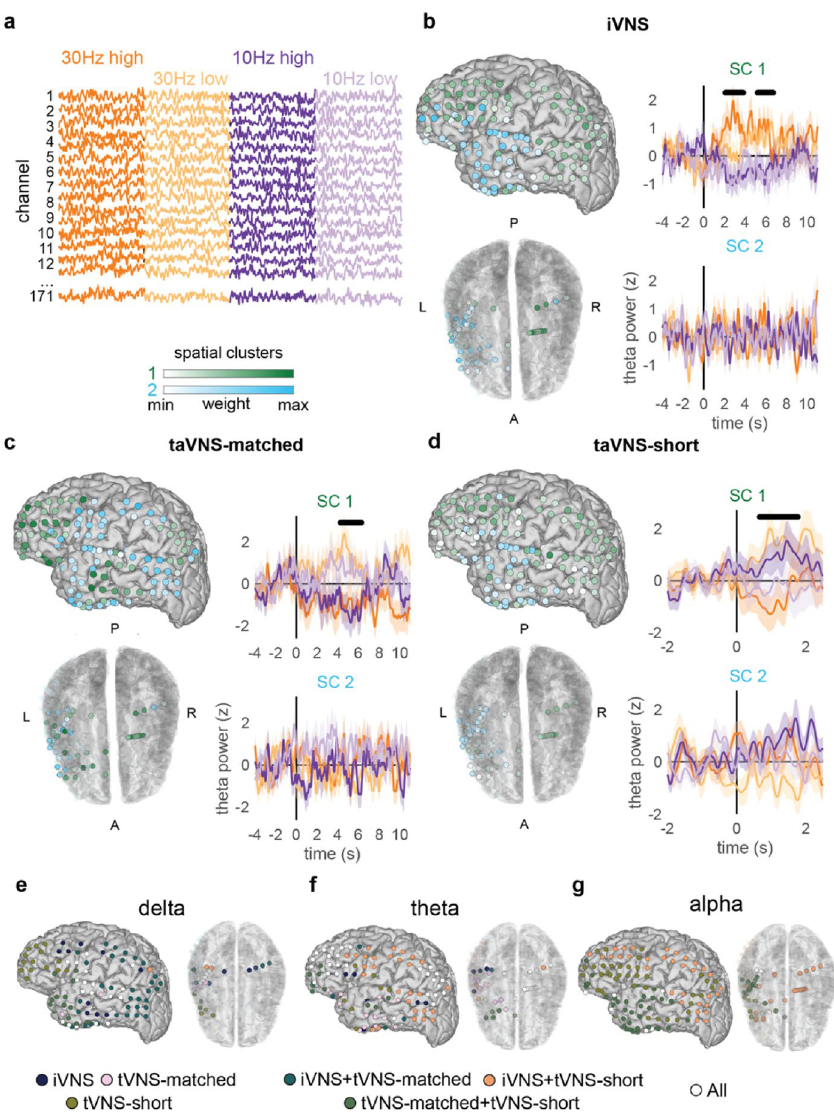
Figure 2. Spatiotemporal patterns of VNS-evoked theta amplitude vary between stimulation modalities. ( a ) Event-related amplitude was averaged over trials by stimulation condition and concatenated into a 2-dimensional channel × time matrix. ( b ) Unsupervised clustering of iVNS data for P1 shows two spatial clusters with correlated activity. Colors indicate cluster assignment and weighting. Timecourses of cluster- weighted theta amplitude for each spatial cluster (SC) show differences between stimulation parameters for SC1 (black bars indicate extent of temporal clusters [p < 0.05; cluster-based permutation tests]; main effect of frequency). ( c ) SCs for taVNS-matched are spatially distinct compared to iVNS. Timecourses of cluster- weighted theta amplitude show a significant effect for SC1, with a main effect of amplitude. ( d ) Clusters for taVNS-short are similar to iVNS, but again exhibit a distinct pattern of parameter-specific evoked timecourses compared to iVNS and taVNS-matched. SC1 exhibited a significant frequency x amplitude interaction effect. ( e ) Spatial overlap of significant effects between modalities for delta band power. Each plotted electrode was assigned to a cluster in which one or more significant effects was found in one or more modalities (designated by color). ( f ) Same as ( e ), for theta band power. Numerous frontal, parieto-occipital, and hippocampus/amygdala electrodes associated with significant effects in all three modalities. ( g ) Same as ( e ), for alpha band power. Extensive overlap between iVNS and tVNS-short across superior fronto-temporal and parietal electrodes, as well as temporal-occipital